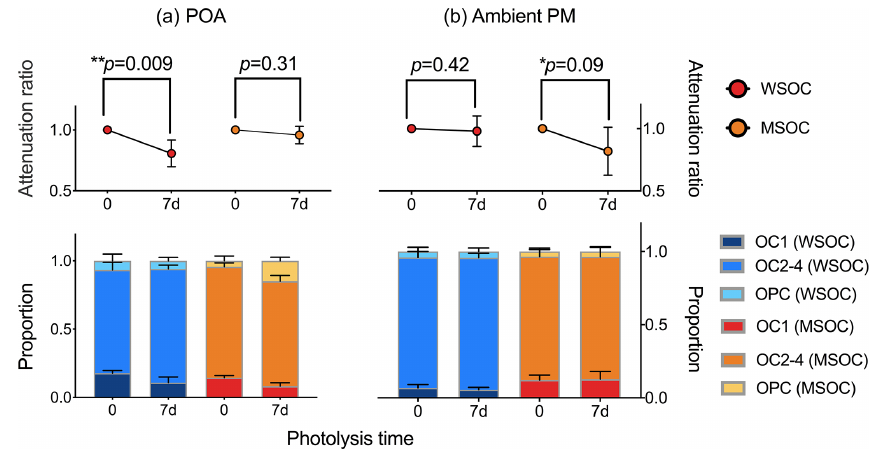
Figure 1. Changes in carbon content before and after photodegradation. The p value is the probability that two sets of data have the same level (two-tailed test). ∗ and ∗∗ The significant difference at the 0.1 and 0.01 levels,